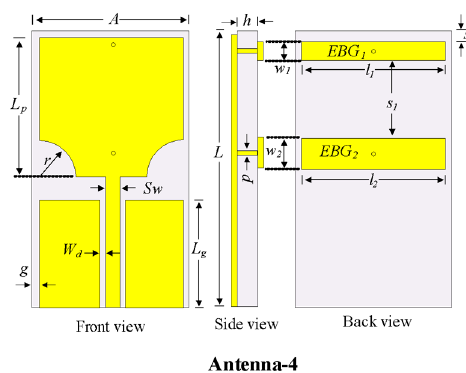
Figure 6. |S 11 | characteristics of Antenna-2 and Antenna-3 .